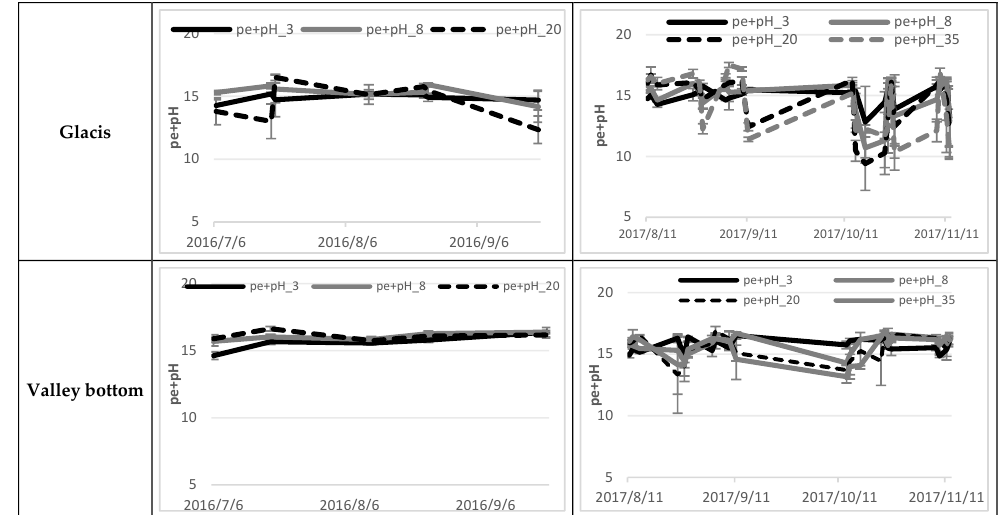
Figure 9. Soil pe + pH at different soil depths during the 2016 and 2017 growing seasons. Error bars indicate the standard errors of the mean.